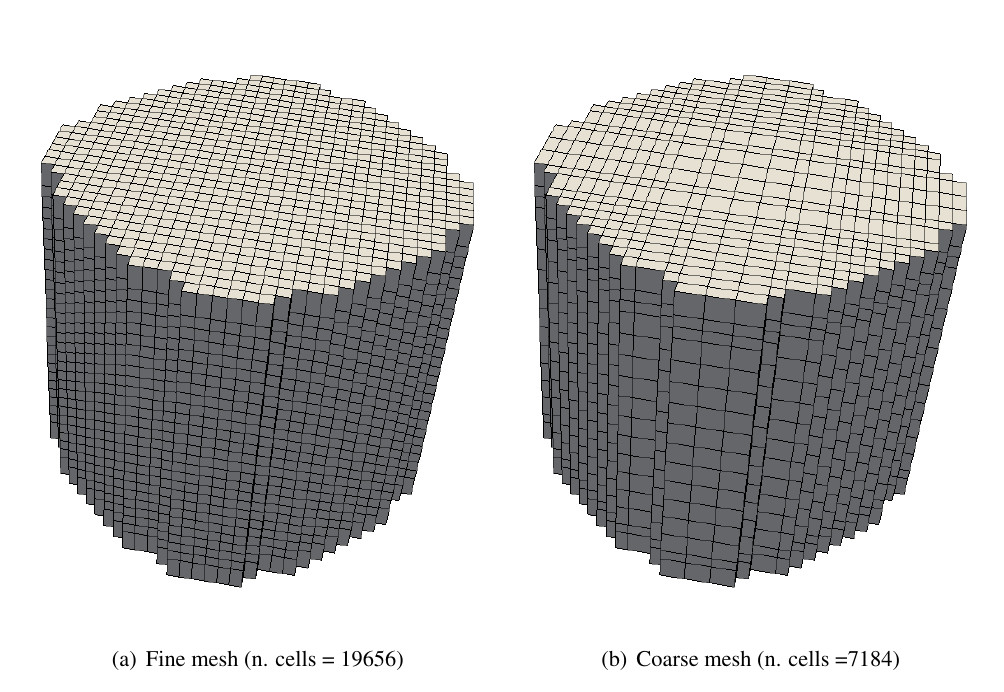
Fig. 2 Meshes for Ringhals